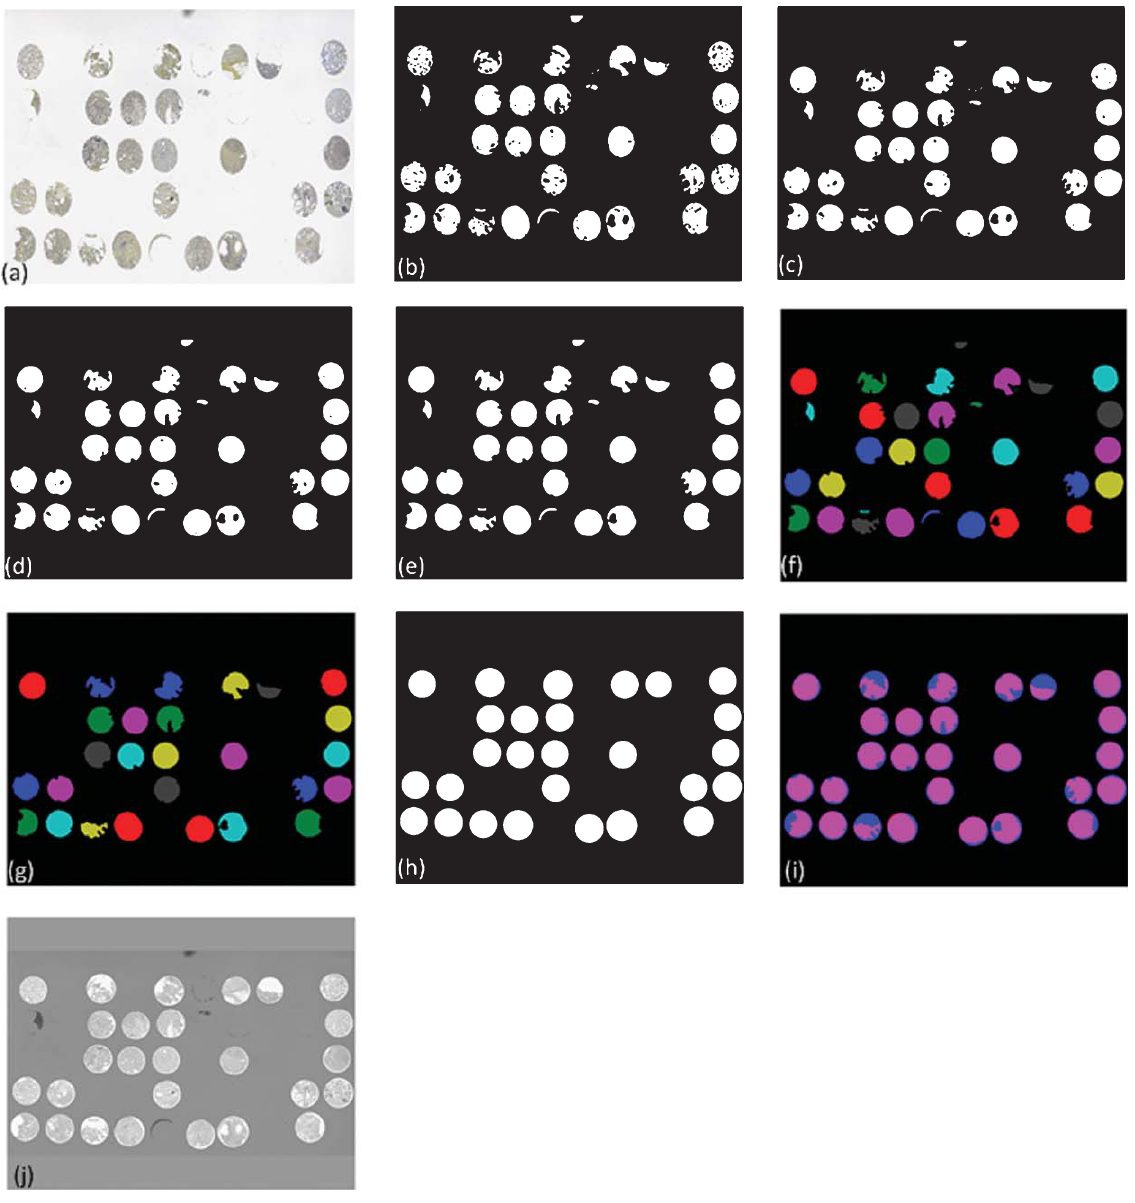
Fig. 3. An example showing the morphological operations (Stage 4) in sequential order and the result of circle reconstruction (Stage 5). (a) Original TMA image. (b) Global thresholding by Otsu’s method. (c) Morphological closing. (d) Median filtering to remove speckles. (e) Region filling of holes. (f) Object labeling by 8-connectivity. (g) Filtering out any small objects by their respective areas using the size condition mentioned in Stage 4. (h) Reconstruction of circles from the objects in (g). (i) Superimposing the objects with their reconstructions, that is (i)=(g)+(h). (j) An overlay of the original TMA image with the reconstructed circles, that is